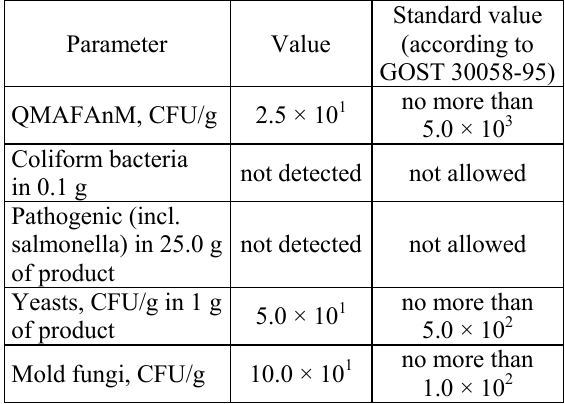
Table 10. Microbiological characteristics of bar with anti-anemic agent Standard value Parameter Value (according to GOST 30058-95) Coliform bacteria not detected not allowed in 0.1 g Pathogenic